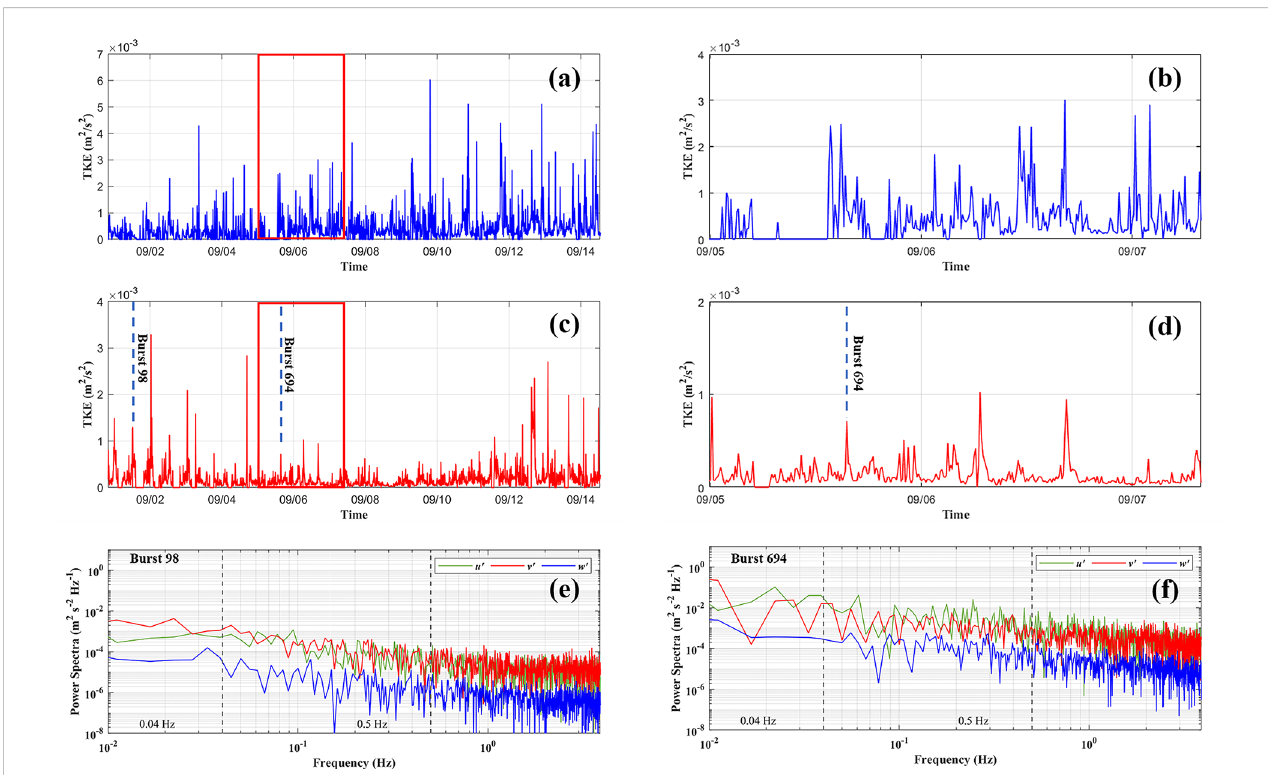
FIGURE 7 Time series of TKE at station S1 (A, B) and S2 (C, D) during Typhoon Lingling, respectively (red boxes indicate the typhoon periods). Power spectra plots of the three current components during normal conditions (E) and Typhoon Lingling (F) . The frequency is indicated by the gray dashed lines, which are 0.04 Hz and 0.5 Hz,